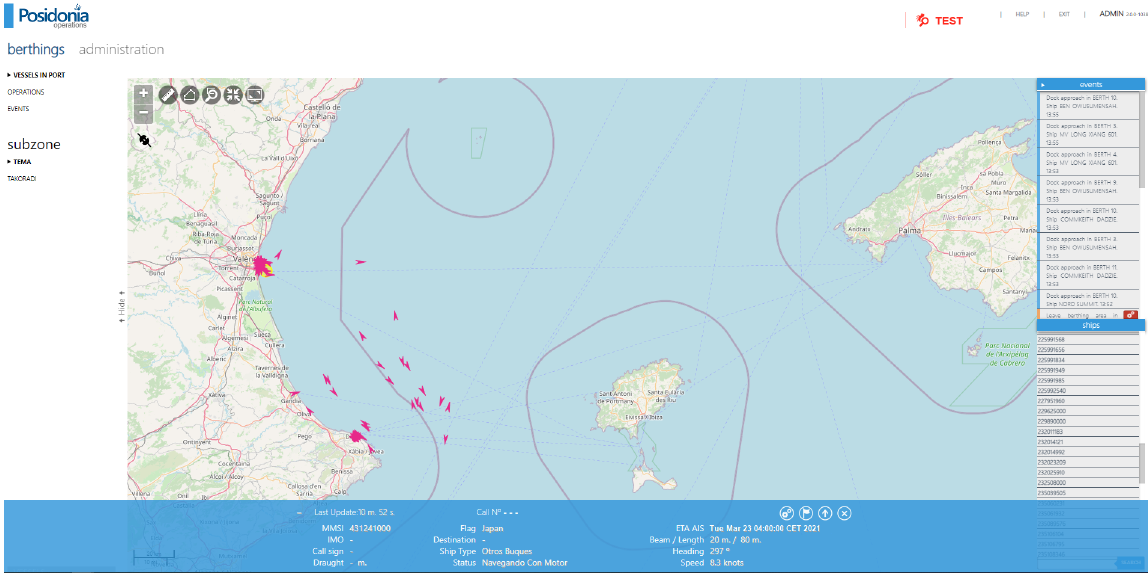
Figure 4. Port service user